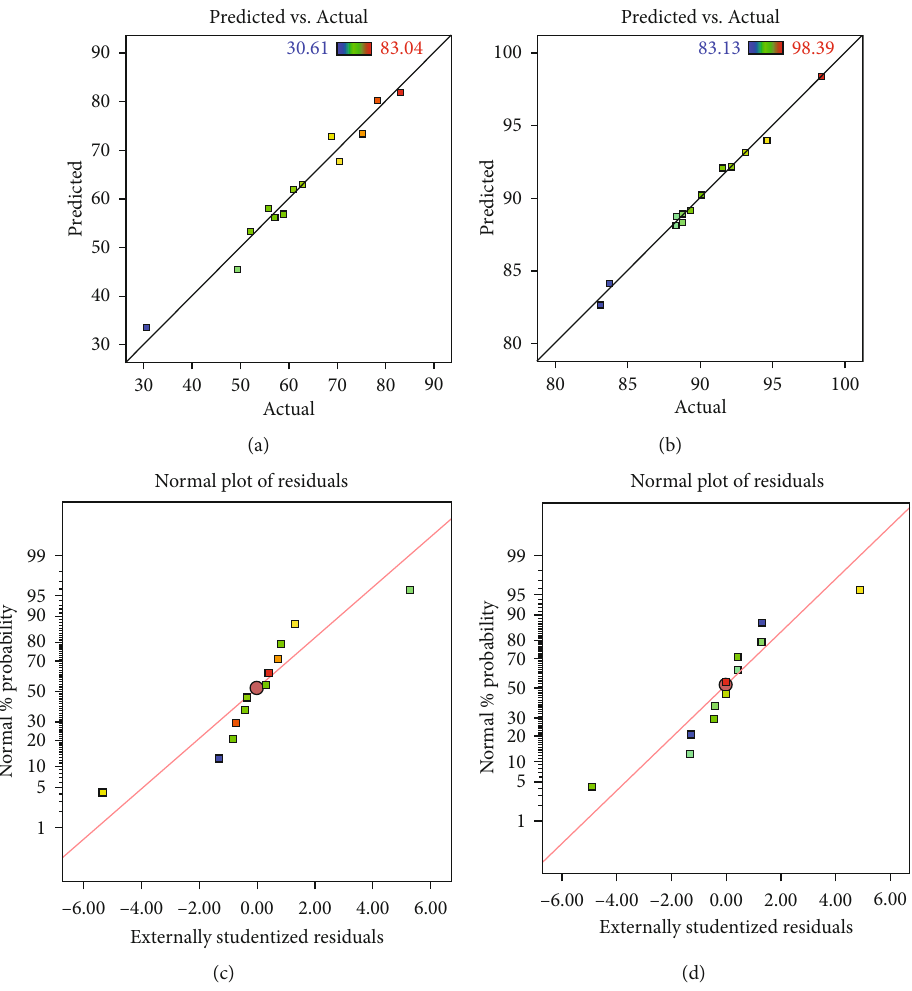
Figure 8: RSM model predicted vs actual data plots and normal residual plots. (a) Predicted and experimental values for COD removal e ffi ciency. (b) Predicted and experimental values for TOC removal e ffi ciency. (c) Normal percentage probability with respect to standardized residuals for COD removal e ffi ciency. (d) Normal percentage probability with respect to standardized residuals for COD removal e ffi